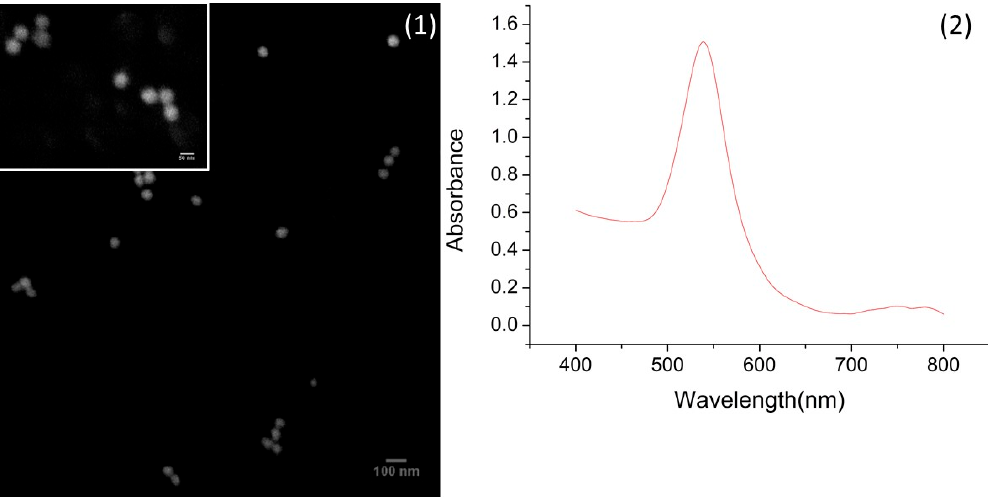
Figure 3. ( 1 ) Scanning electron microscope (SEM) images of 46-nm spherical nanoparticles and ( 2 ) UV-vis spectra.